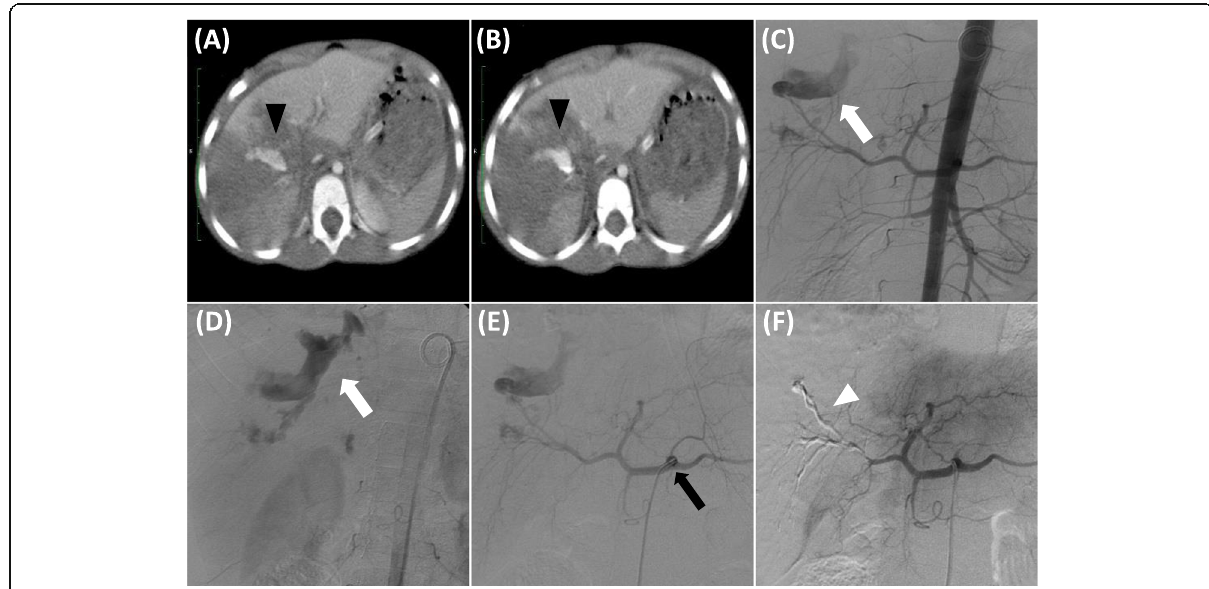
Fig. 2 ( a, b ) CT image arterial phase after endovenous contrast injection, depicting contrast deposition inside the right liver lobe (black arrowhead). ( c, d ) DSA with Pigtail cateter injection in aorta showing contrast extravasation (white arrow), seen in image ( e ) with a DSA performed by a Cobra 2 catheter (black arrow) in the celiac trunk. ( f ) After embolization, glue cast (white arrowhead) in a subtracted image in the liver territory after embolization with complete superseletiva exclusion of the injured vessel from the circulation